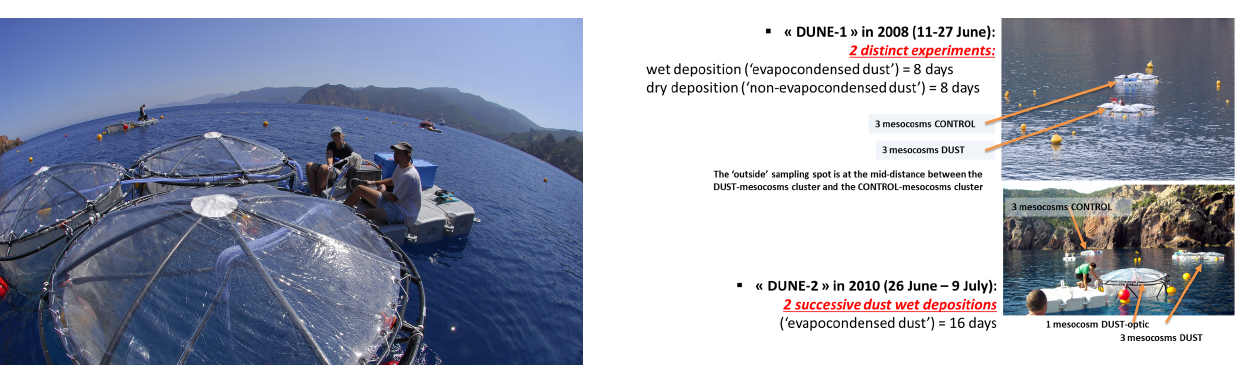
Fig. 8. Implementation of the two mesocosm experiments in the Scandola preservation area